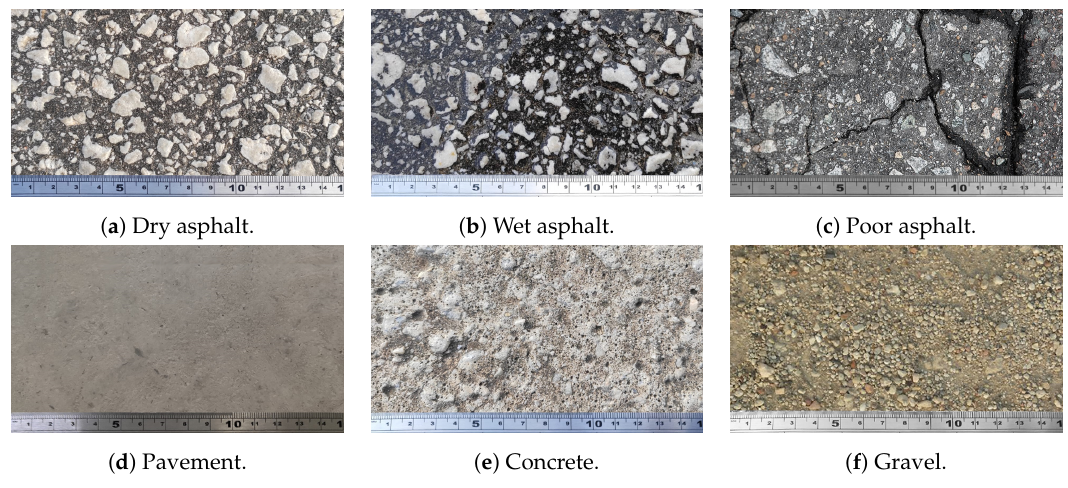
Figure 1. Sample of test